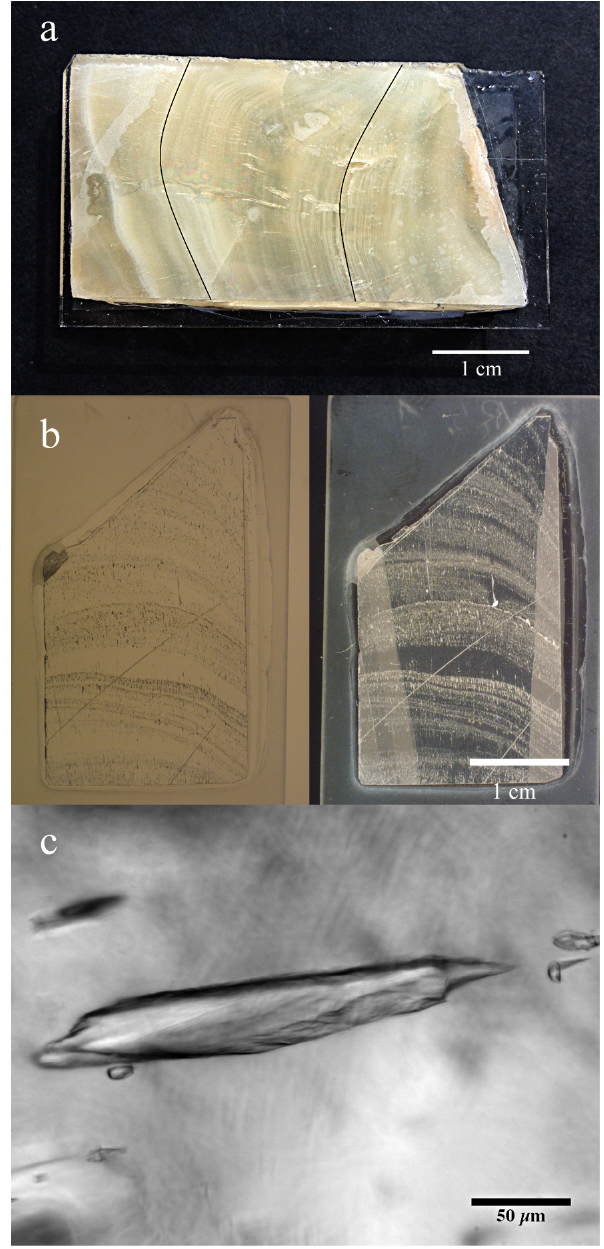
Figure 2. Speleothem sample. (a) Conditioning of the sample be- fore being cut with a wire saw. Growth laminae are clearly visible. (b) Speleothem thin sections with their laminae. Fluid inclusions are visible in both cross-polarised (black) or bright field view (white). (c) Enlargement of single fluid